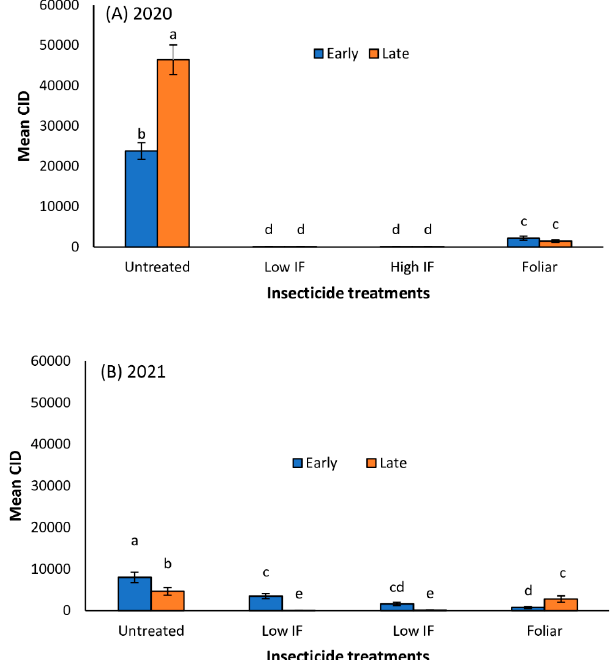
Figure 4. Mean (±SE) cumulative insect days (CID) in early and late planted forage sorghum treated with flupyradifurone in-furrow (IF) or foliar in 2020 ( A ) and 2021 ( B ) in Florence, SC. Means with different letters are significantly different (sequential Bonferroni test, p < 0.05) among all four insecticide treatments and planting date.